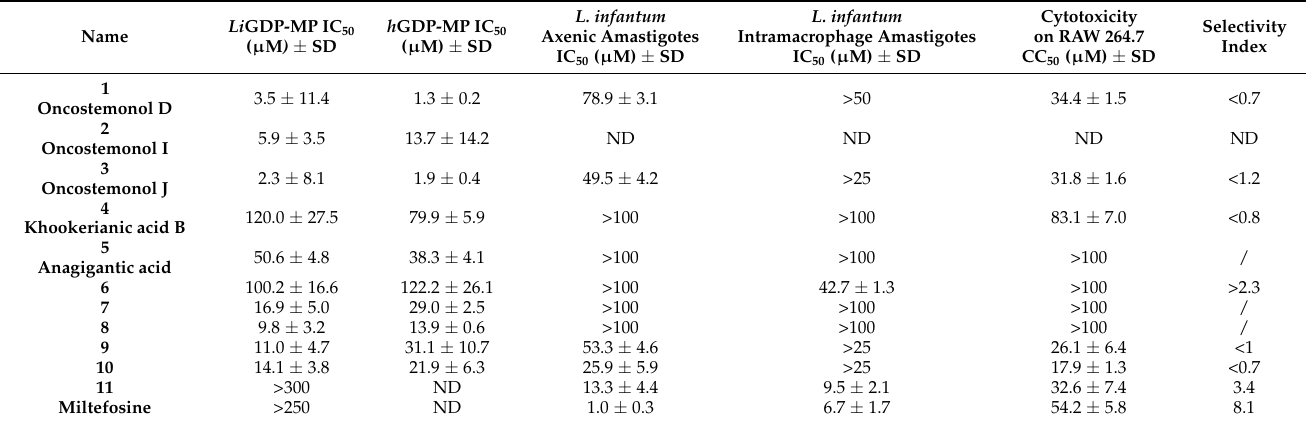
Table 1. Evaluation of resorcinol derivatives on Li GDP-MP, h GDP-MP, and on L. infantum axenic and intramacrophage amastigotes, and their cytotoxicity.